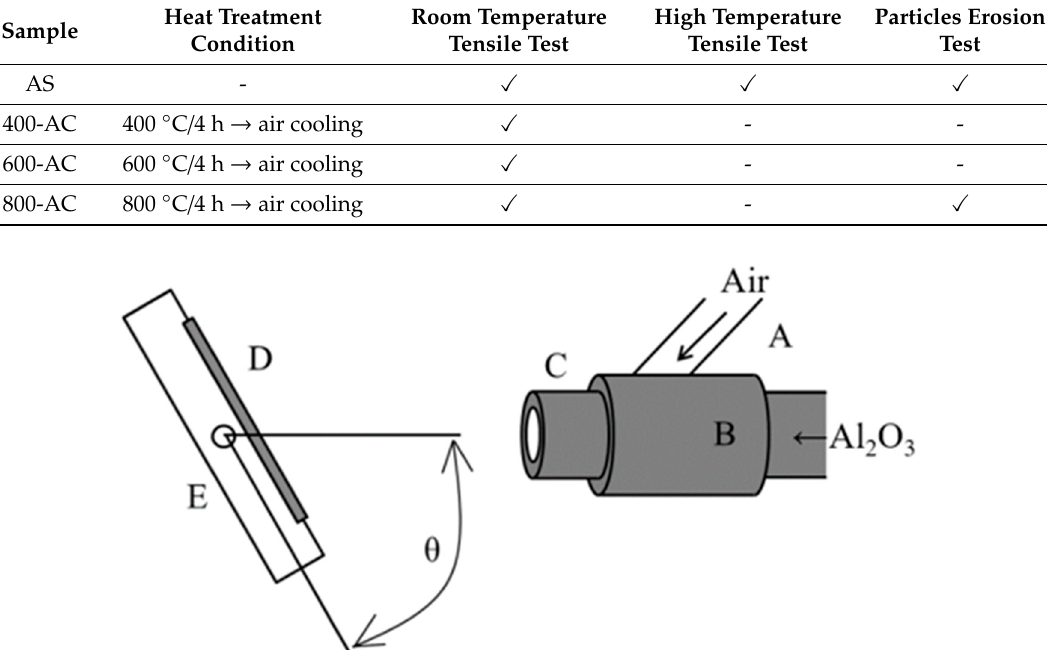
Table 3. Heat treatment condition and measurements.